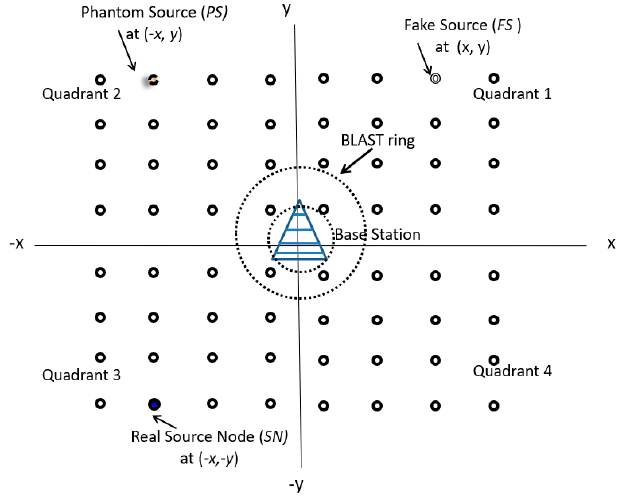
Figure 6. Schematic of proposed model.